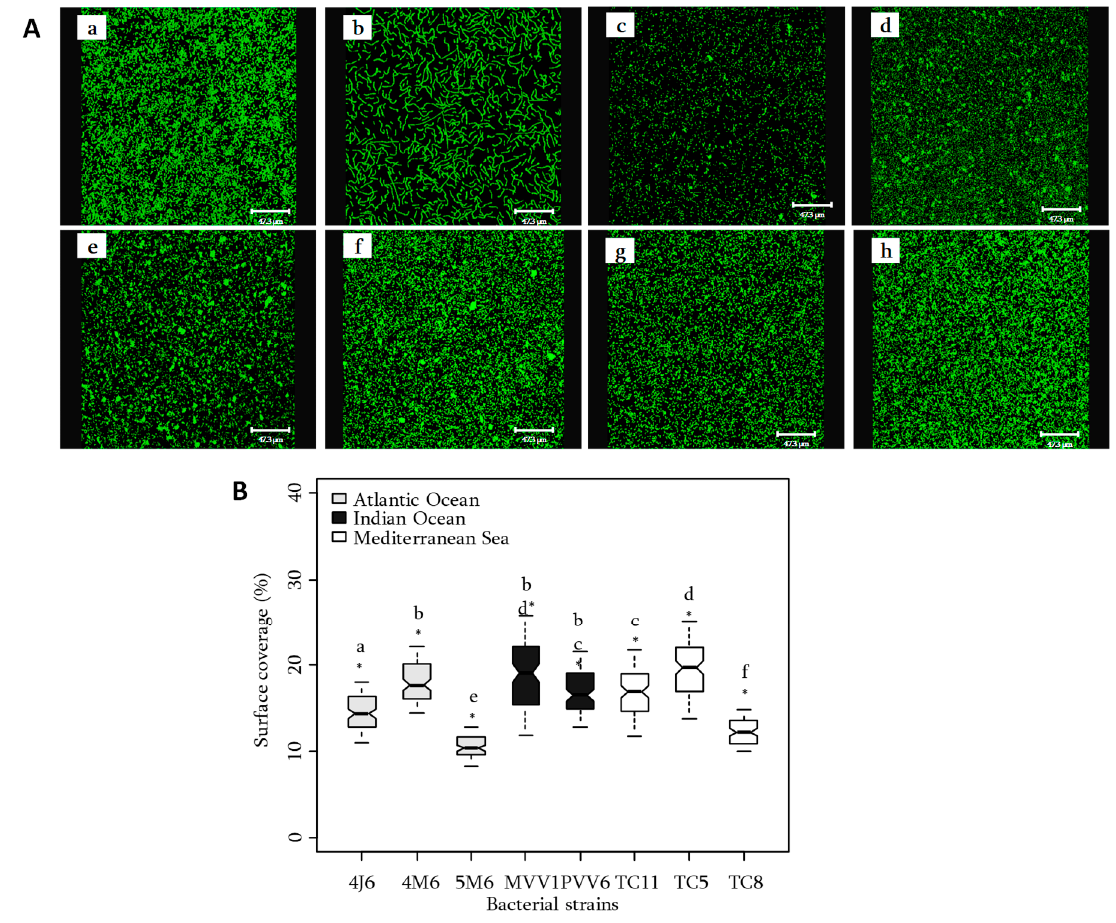
Figure 2. ( A ) CLSM observations of the marine bacterial adhesion with syto9®after 3 h (ASW medium, 20 ◦ C). ( a ) Paracoccus sp. 4M6, ( b ) Bacillus sp. 4J6, ( c ) Pseudoalteromonas sp. 5M6, ( d ) Polibacter sp.